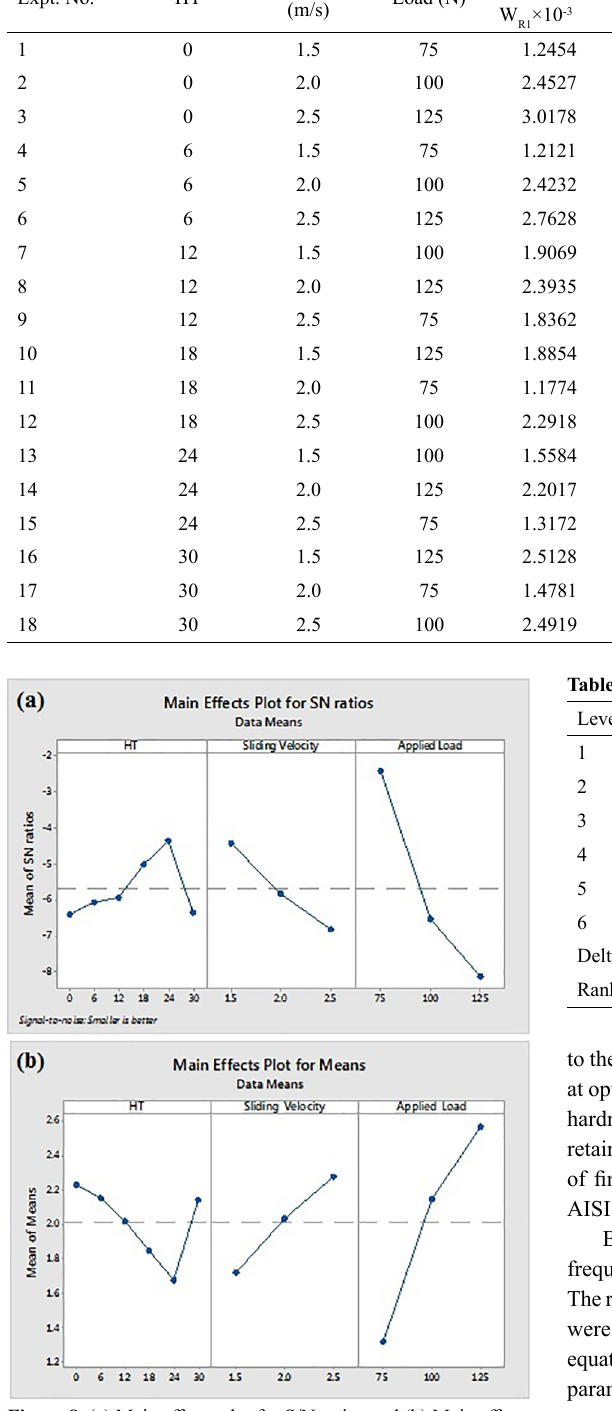
Figure 8. (a) Main effects plot for S/N ratios and (b) Main effects plot for means